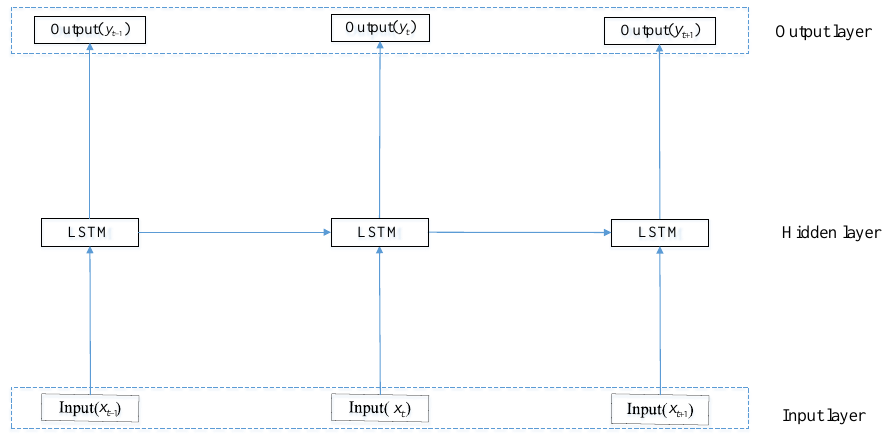
Figure 1. LSTM Figure 1. LSTM network.